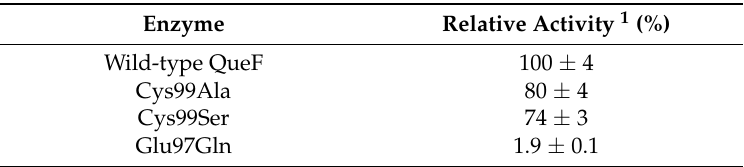
Table 1. Relative catalytic activity of wild-type and mutant QueF